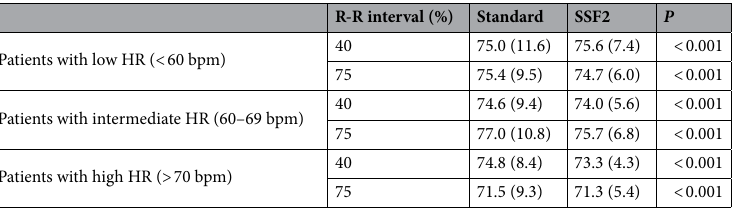
Table 5. Comparison of SD of the aortic annulus perimeter (mm) of scans subjected to standard- and SSF2 reconstruction. HR Heart rate, bpm Beats per minute. Values are the mean (SD).